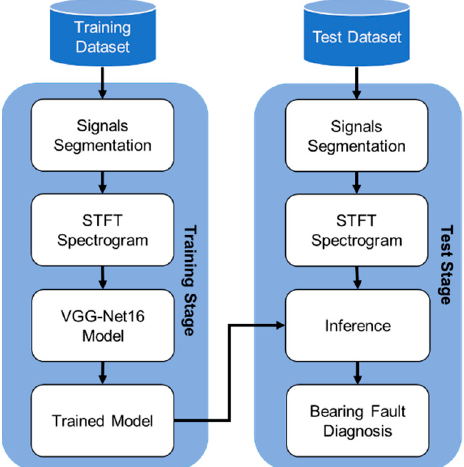
Figure 1. Proposed bearing fault diagnosis method using vibration signals.